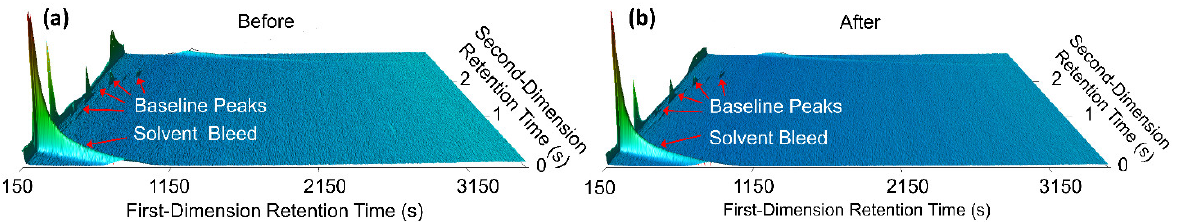
Figure 6. Volume percentages determined for carbonates in SBS #1 ( a ), SBS #2 ( b ), and COES ( c ).